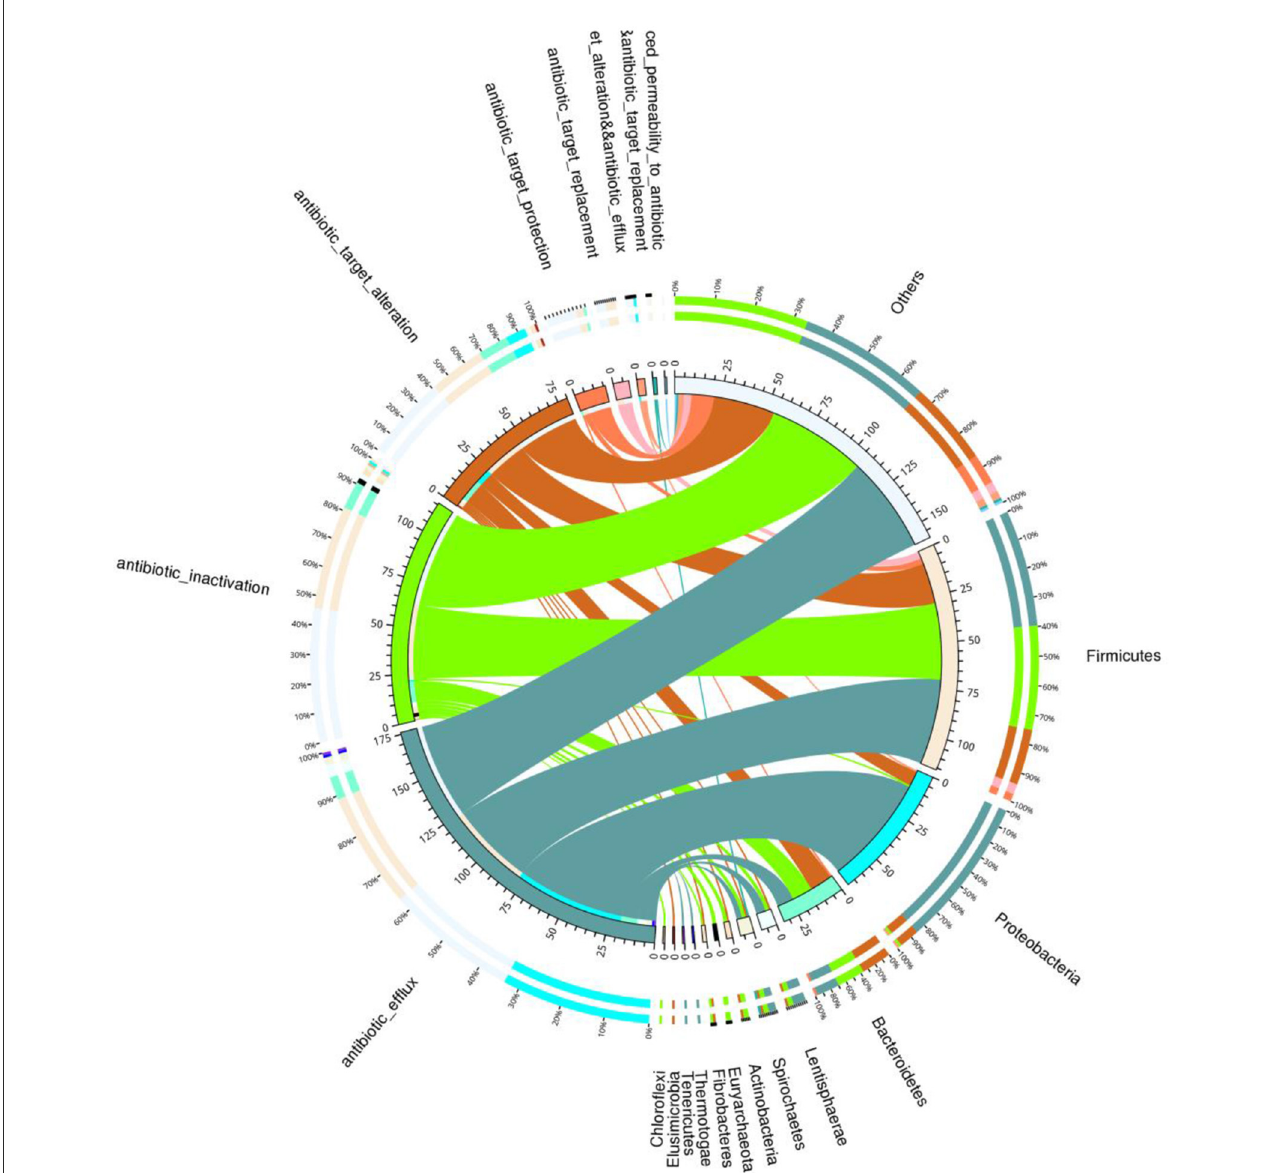
FIGURE8 Circos diagram summarizing the relationship between the resistance mechanism and the microbial taxa (combined data from both African and Asian elephants). The circos diagram is divided into two parts, with phylum-level taxa information on the right and resistance mechanism information on the left. For the outer circle, the left side is the relative proportion of the resistance genes coding for corresponding resistance mechanism within each taxa. The right side is the relative proportion of the resistance genes coding each resistance mechanism within the taxa. For the inner circle, different colors represent different taxa and resistance mechanisms, and the scale is the number of genes. The left side is the sum of the number of resistance genes coding corresponding resistance mechanism in different taxa. The right side is the sum of the number of resistance genes coding different resistance mechanisms within each